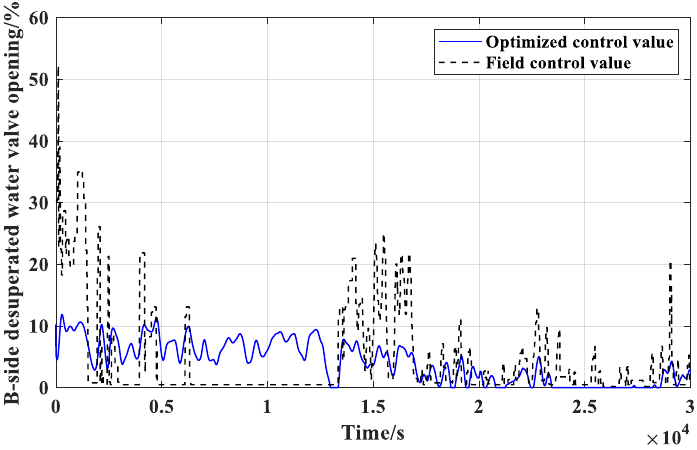
Figure 11. B-side control-variable comparison.